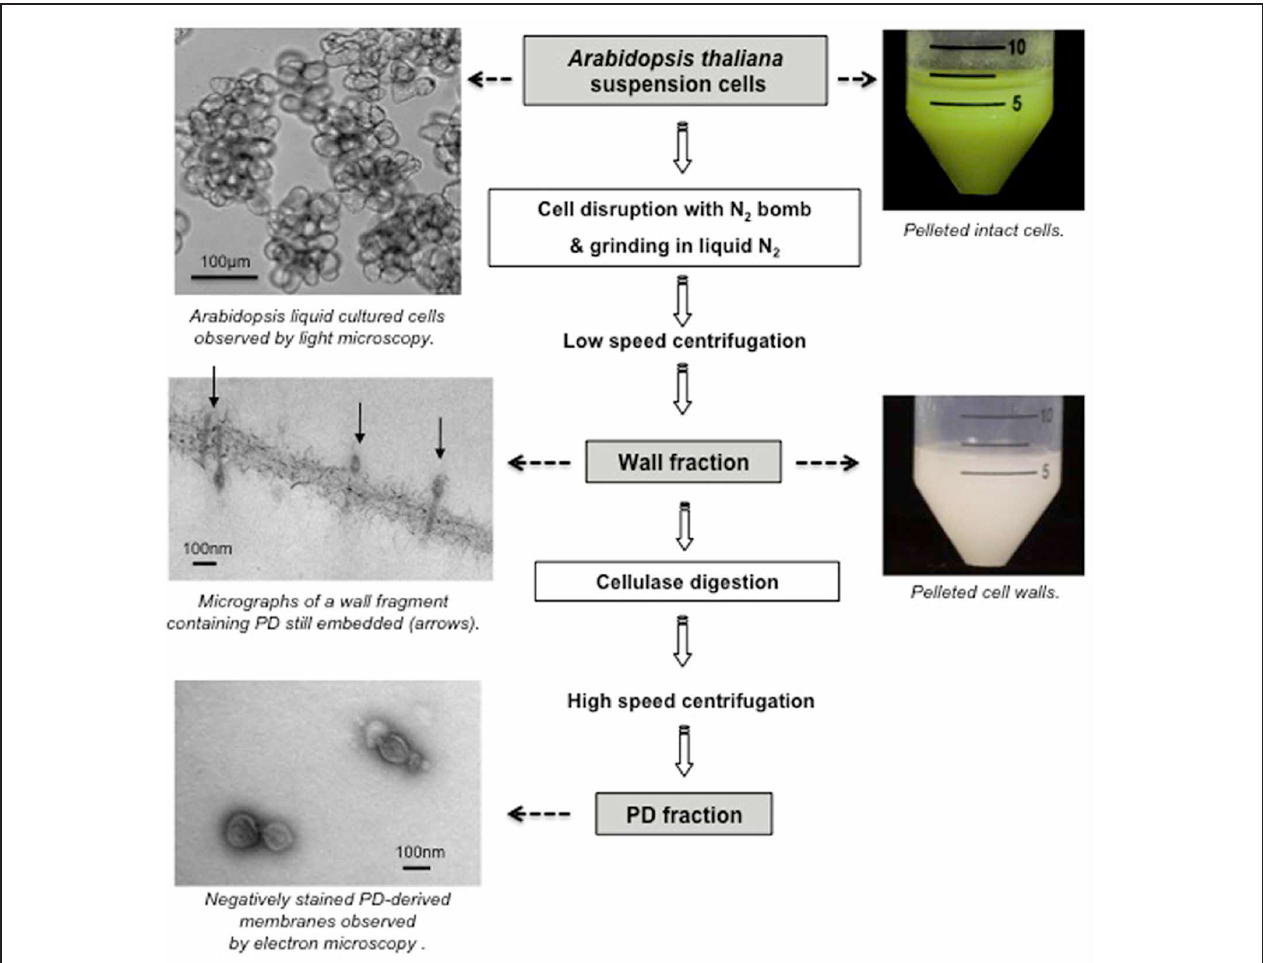
FIGURE 2 | Purification of PD-enriched wall fraction and “free” PD fraction from Arabidopsis thaliana suspension